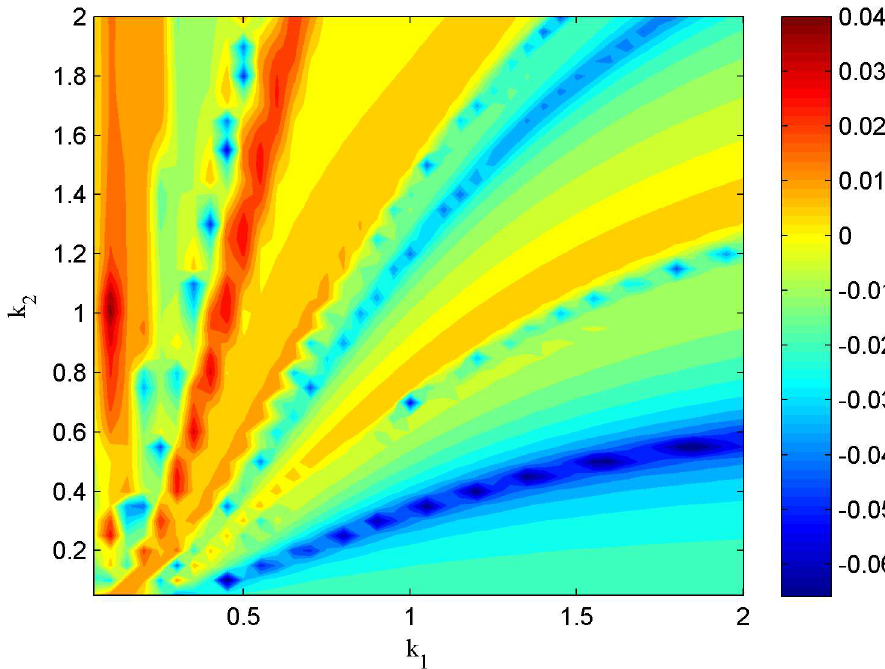
Fig 8. The largest Lyapunov exponent in the two-parameter region ( k 1 , k 2 ).